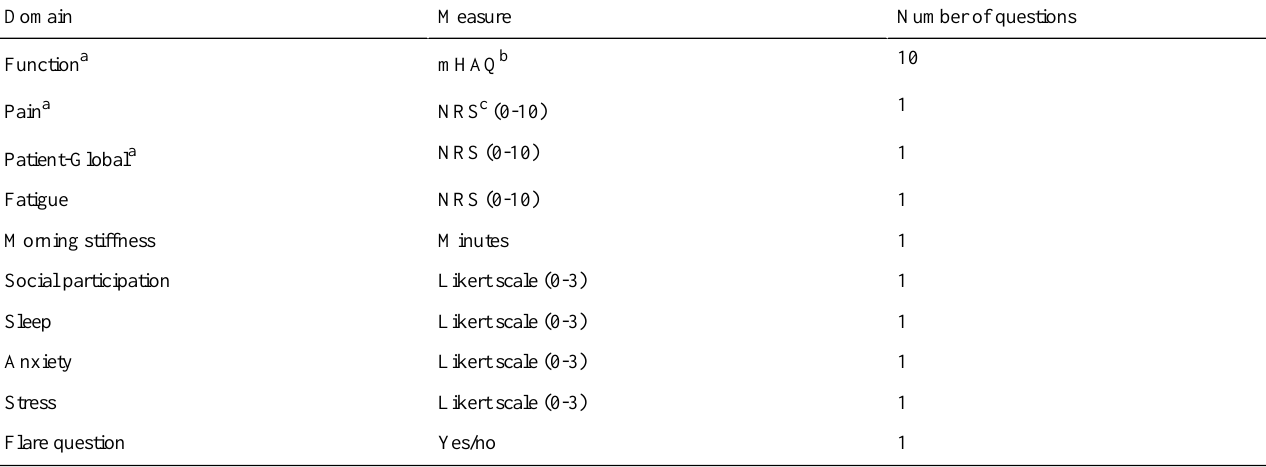
Table 1. Self-assessment questionnaire in the MijnReuma Reade App.